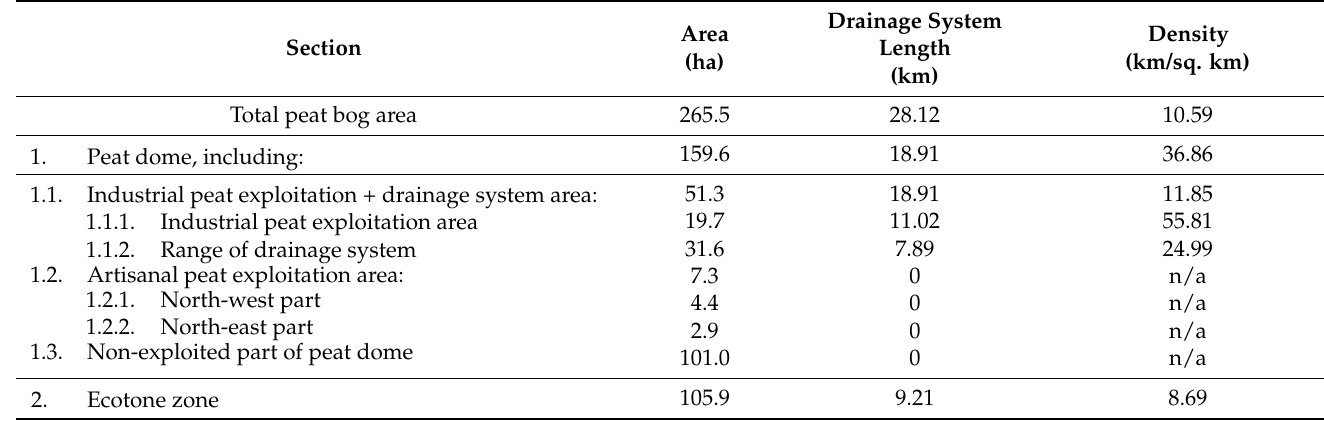
Table 1. The results of the measurement of the area and drainage system of the Baligówka peat bog. Numbers as in Figure 4.